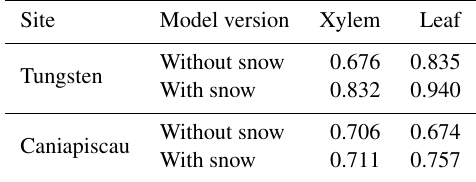
Table 5. Mode of the probability density function for the coeffi- cients of determination ( R 2 ) in Fig. 9 between the reference simu- lations and the water source (xylem) experiments and the leaf water enrichment experiments for the model without snow and with snow and for the two sites of Tungsten and